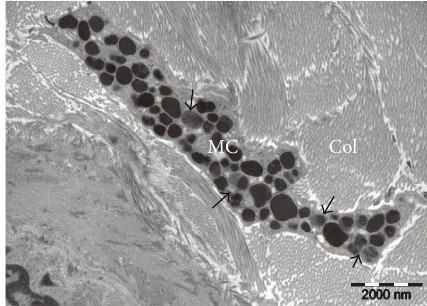
Figure 6: Electron micrograph from Stress 21 days rat group. A dermal mast cell (MC) with dense granules and granules that show altered electron densities (arrows), indicating a process of mast cell activation. Collagen fibers (Col) in the surrounding